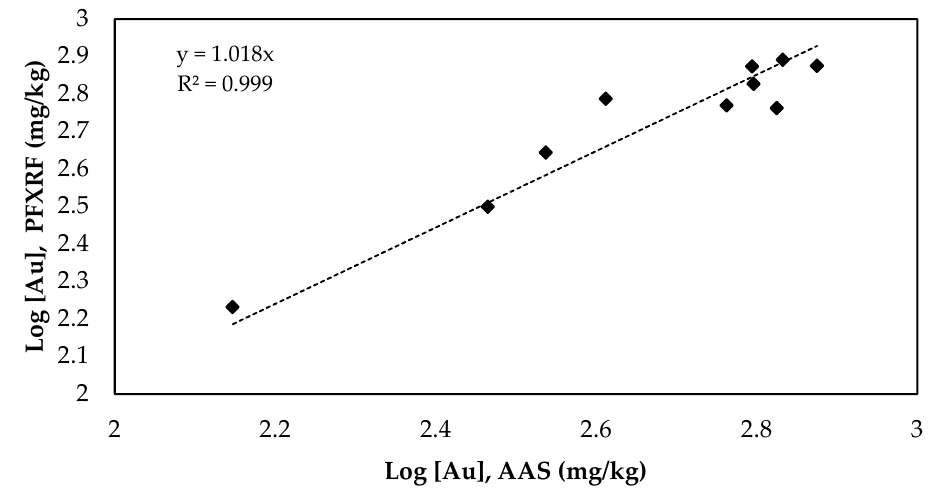
Figure 6. Regression of FPXRF data and AAS analysis. Table 6 and Figure 7 report the results of the statistical analysis. Table 6. Statistical results of the Au concentration.